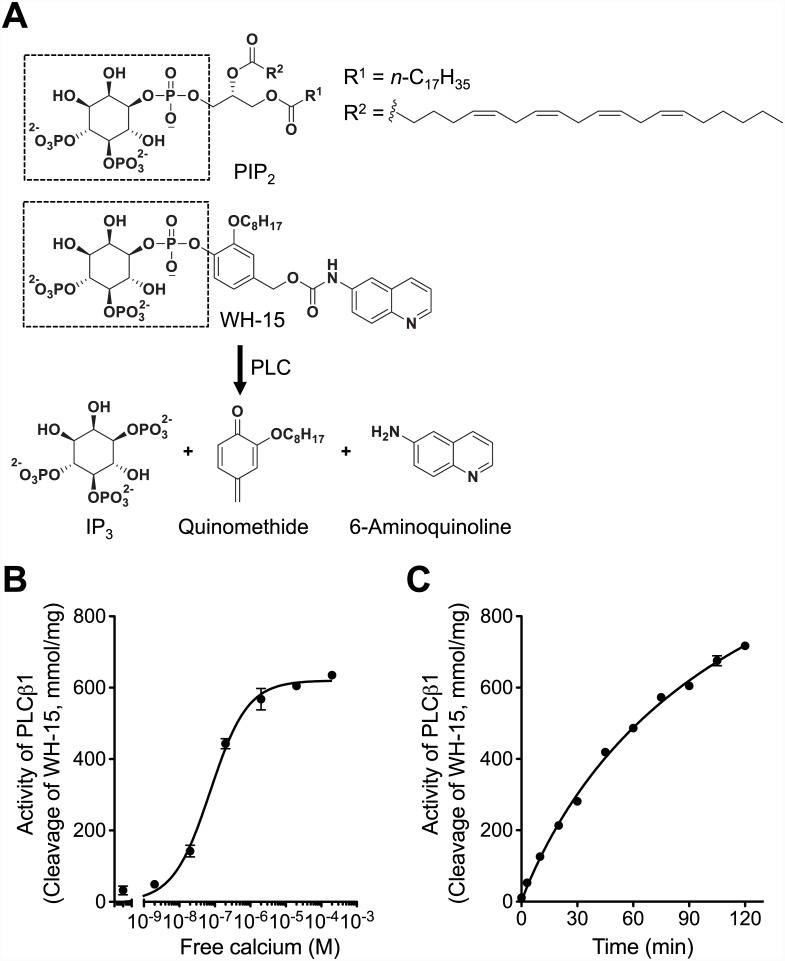

In vitro assay of PLC enzyme activity.(A) WH-15, a PIP2 analog, is cleaved by PLCs into inositol 1,4,5-triphosphate (IP3), a quinomethide derivative, and 6-aminoquinoline. Fluorescence from 6-aminoquinoline is used to estimate PLC activity. WH-15 has the same inositol as PIP2 that is recognized and cleaved by PLC (dotted rectangle box). (B) Ca2+-dependent activation of PLCβ1. WH-15 (30 μM) was hydrolyzed by recombinant PLCβ1 protein (20 ng) at different free Ca2+ concentrations for 90 min. (C) Real-time PLCβ1 activity was measured with a fixed free Ca2+ concentration at 16.4 μM. Error bars for many points are smaller than the symbol size. n = 3 for each condition.